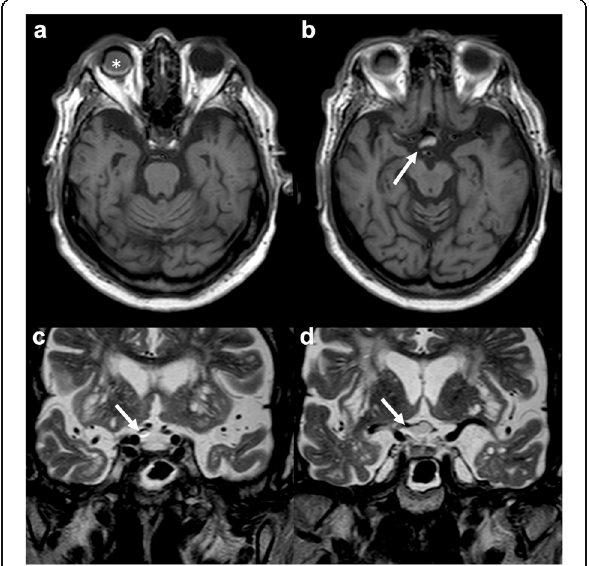
Fig. 9 Silicon oil migration. Axial T1-weighted ( a , b ) and coronal T2- weighted ( c , d ) images demonstrating migration of silicon oil used to treat right retinal detachment (asterisk in a ) through the right optic nerve sheath up to the right half of the optic chiasm (arrow in b , c , and d ). The migrated material has heterogeneous signal also due to chemical shift